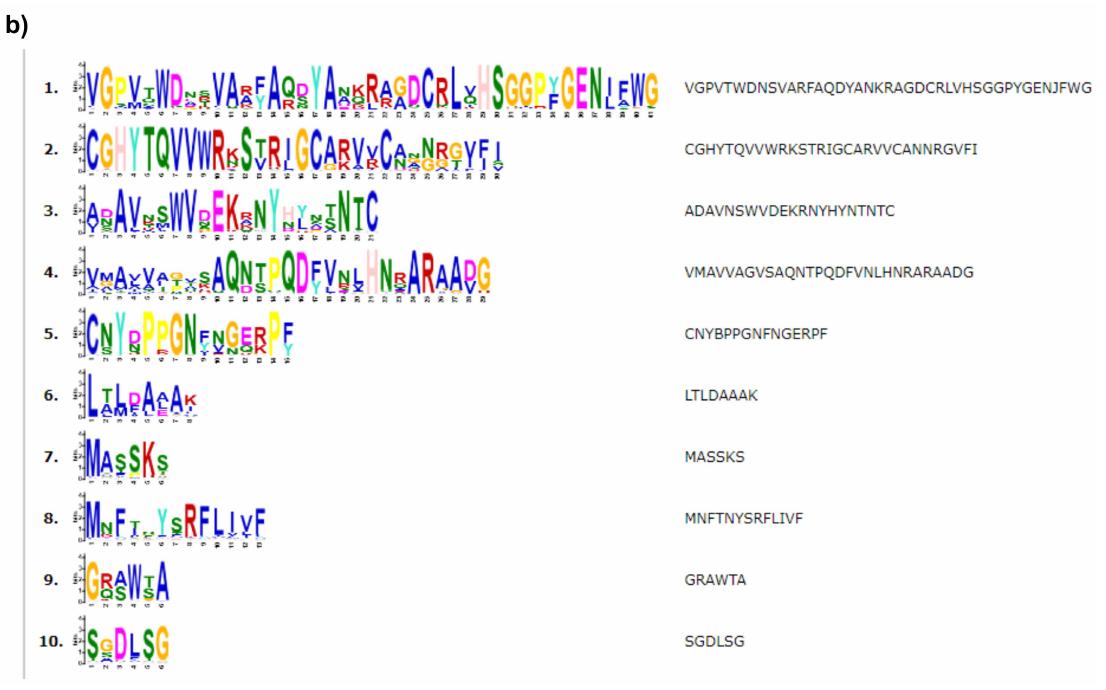
Figure 3. ( a ) Phylogenetic analysis of 21 different pathogen-related proteins oat ( GenBank OP132412